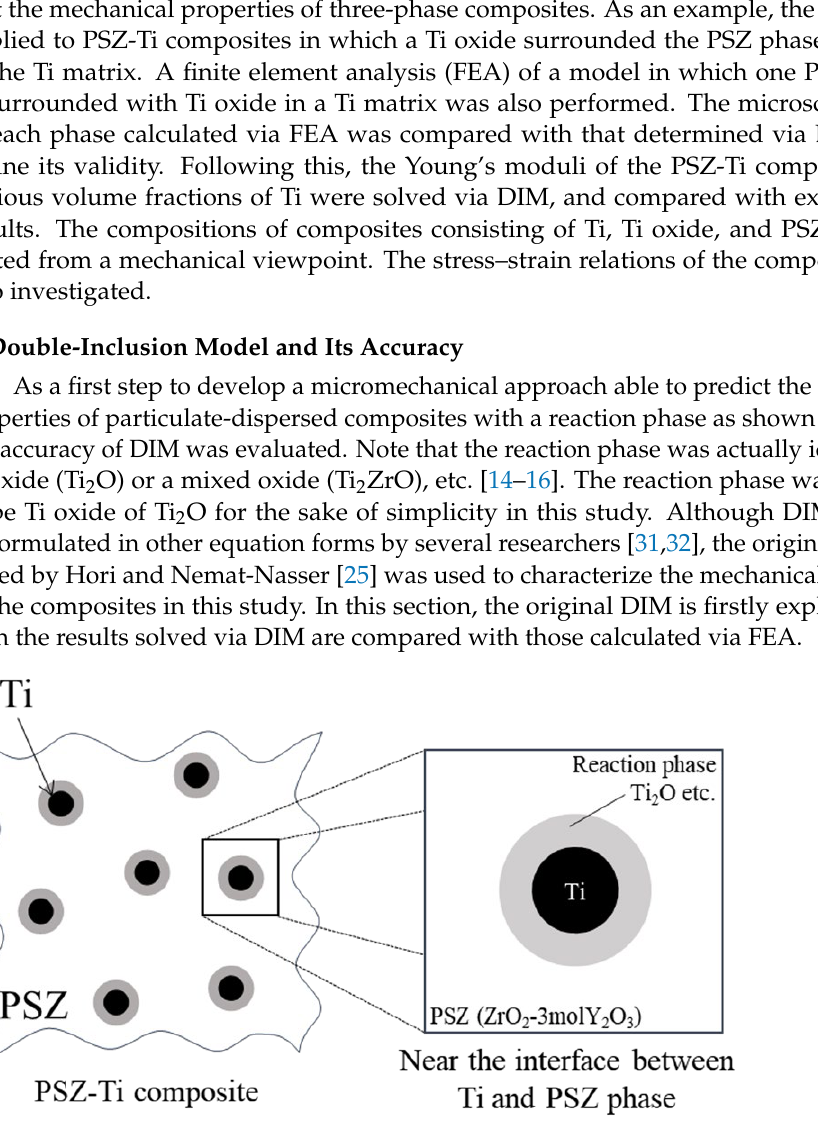
Figure 2. Mechanical properties of PSZ-Ti composites fabricated via powder metallurgy technique [15]. ( a ) Bending stress–strain curves of composites with various volume fractions of Ti fabricated via SPS; ( b ) Young’s modulus as a function of volume fraction of Ti for composites obtained via HP and SPS.